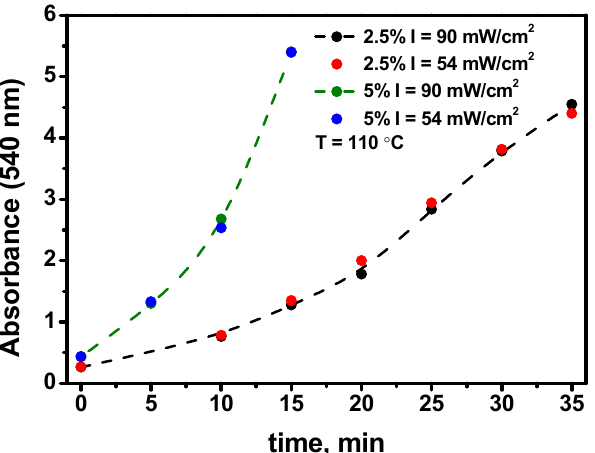
Figure 7. Comparison of the dependence of the absorbance of samples on the heating time at 110°C after irradiation at different intensities and with the same exposure.